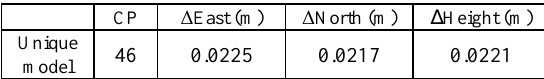
Figure 24. Normal distributions of coordinate deviations between points from TLS and photogrammetric models.